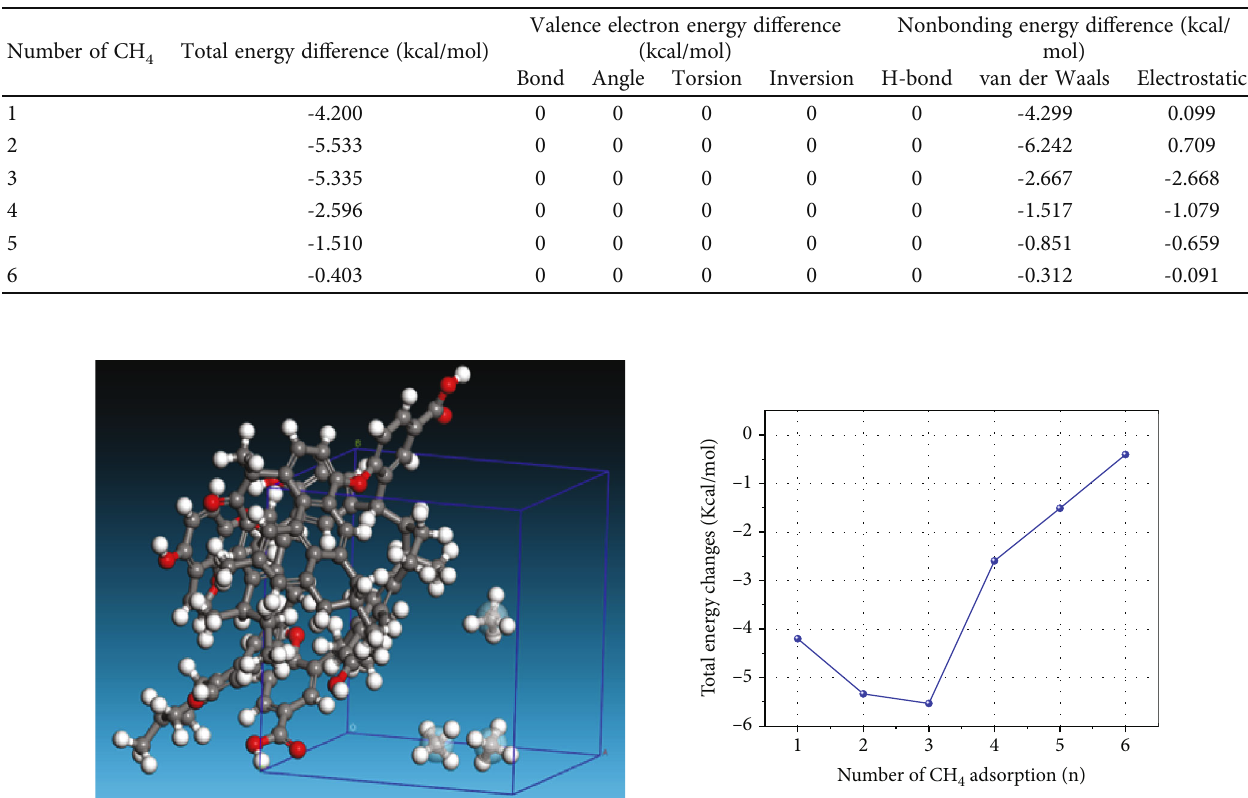
Figure 2: Saturated molecular structure model and total system energy of the long- fl ame coal molecule-absorbing methane